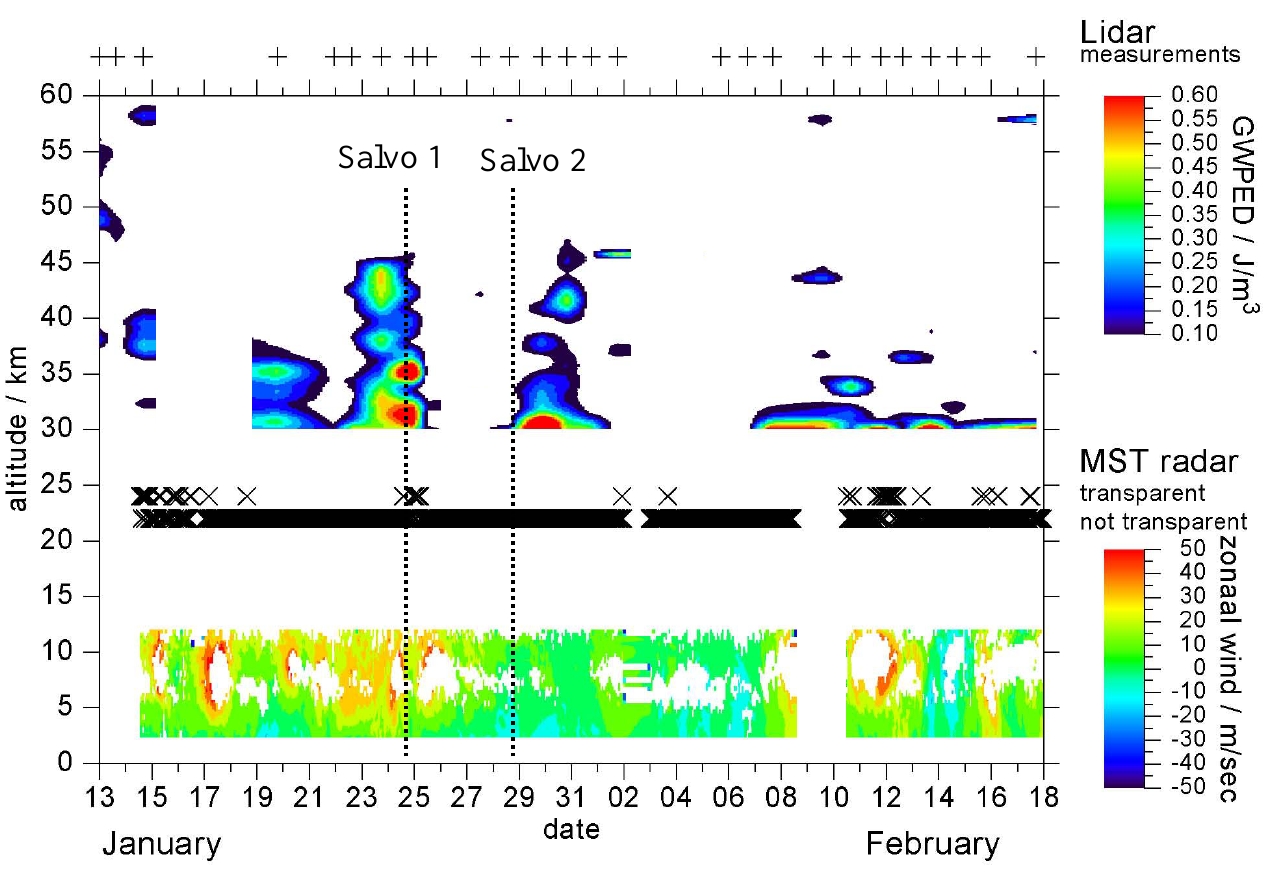
Fig. 3. Development of zonal wind as observed by Esrange MST radar ESRAD in the troposphere and the gravity wave potential energy density as observed by the U. Bonn lidar in the stratosphere. The abscissa gives the date of January/February 2003, the ordinate the altitude in km and the colour code in the lower part of the plot the zonal wind in m/s. The sign determines the direction of the zonal wind (+: eastward, − : westward). Crosses at about 25km mark days when the excitation and propagation of orographically induced gravity waves was possible according to the wind data. The second colour bar in the upper part of the figure describes the GWPED vol in J/m 3 . Crosses at the top of the figure mark the measurement times of the